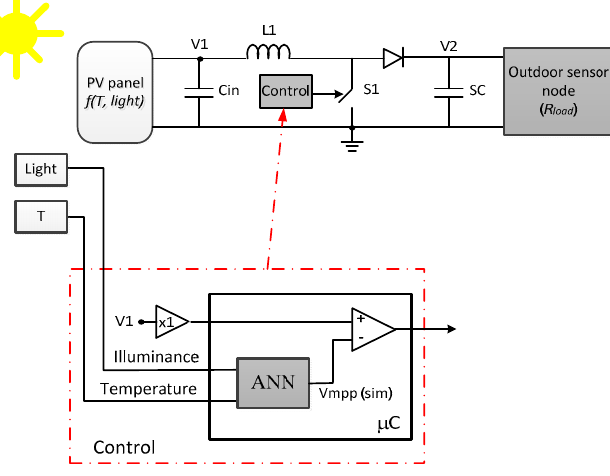
Figure 10. Proposed ANN-based VOC MPPT.